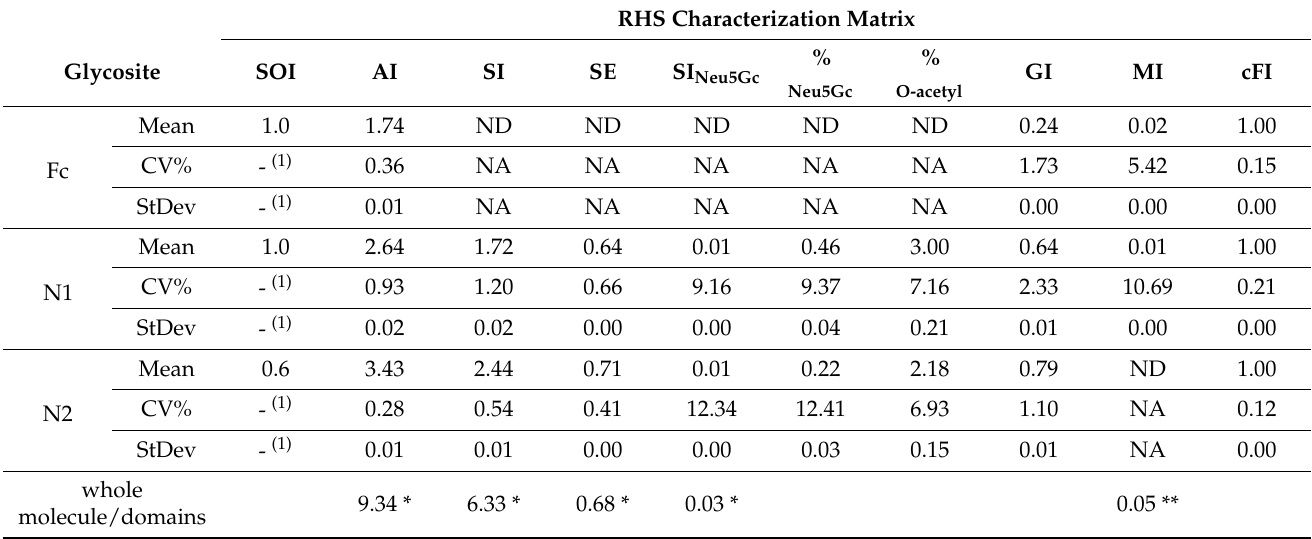
Table A1. Repeatability study applied to RHS (2 operators, 3 independent preparations, 2 replicates per preparation; n = (12)) samples analyzed in the same analytical session.